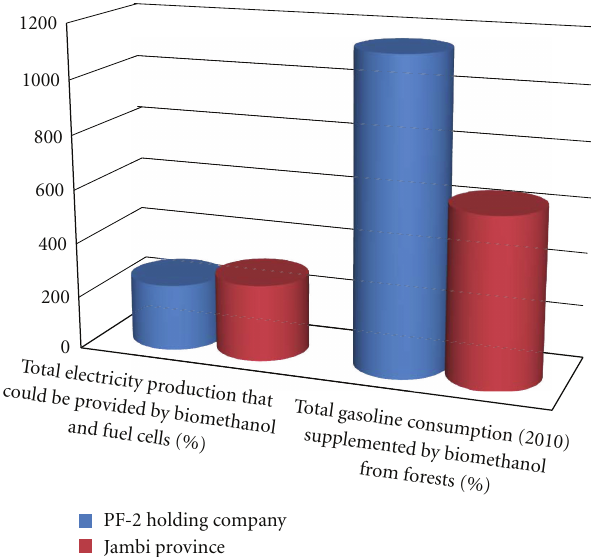
Figure 7: The Proportion APP and Jambi Province Consumption of Gasoline and Electricity Production that can be substituted by